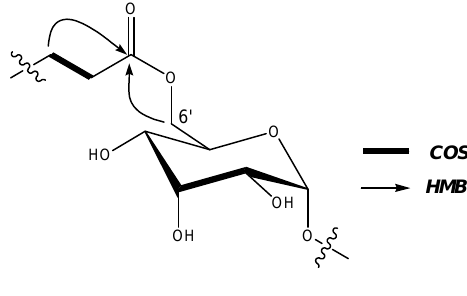
Figure 3. Partial HMBC and COSY correlation of the synthetic